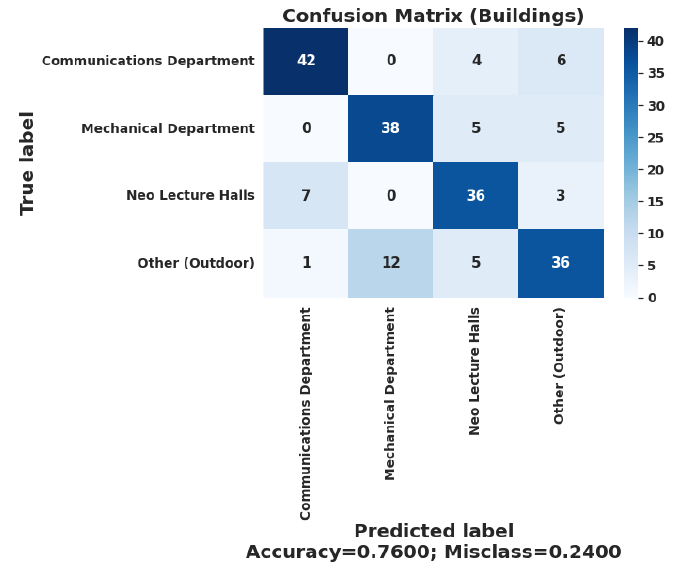
Figure 24. Confusion matrix of the overall system performance with MF-ML models.